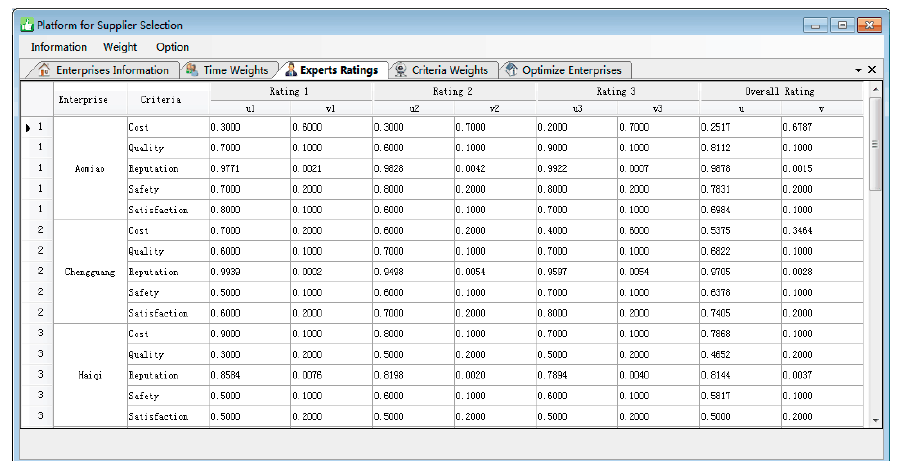
Figure 2. Graphical user interfaces (GUI) of expert ratings.